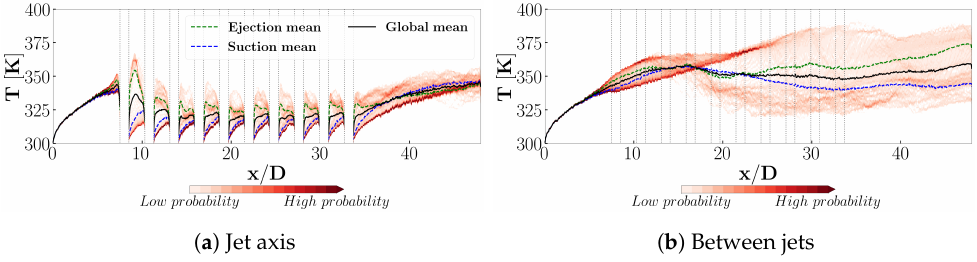
Figure 8. Probability density functions of wall temperature obtained with Φ = 1500 W.m − 2